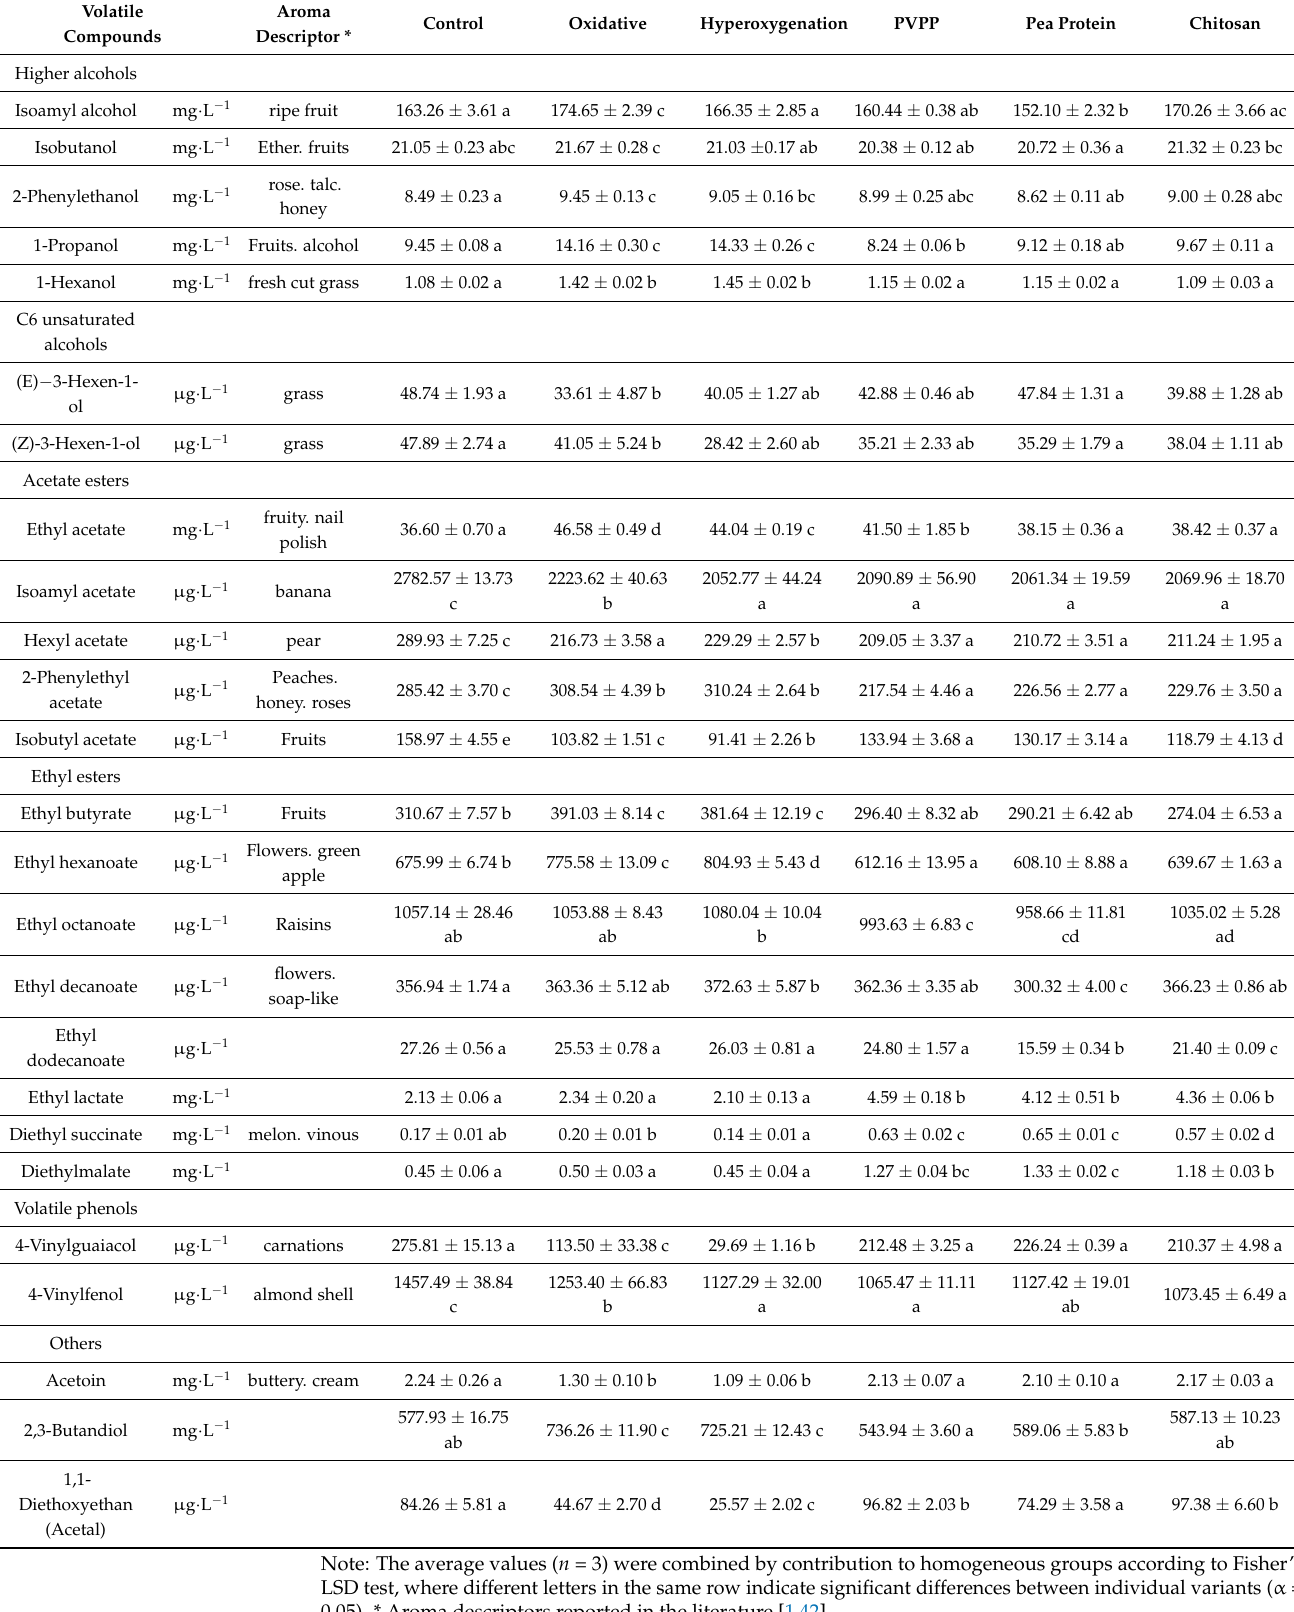
Table 4. Concentrations of volatile organic compounds in final